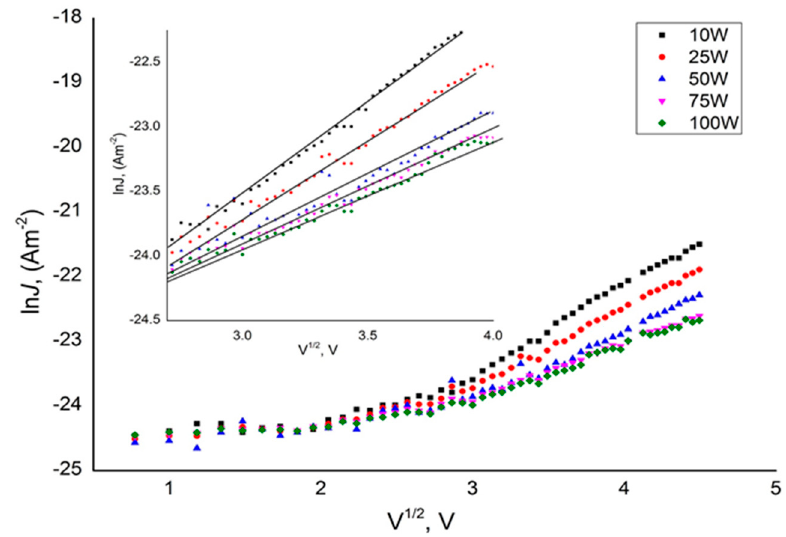
Figure 6. Variation of ln J with square root of applied voltage for pelargonium plasma polymer thin films fabricated at different deposition powers.